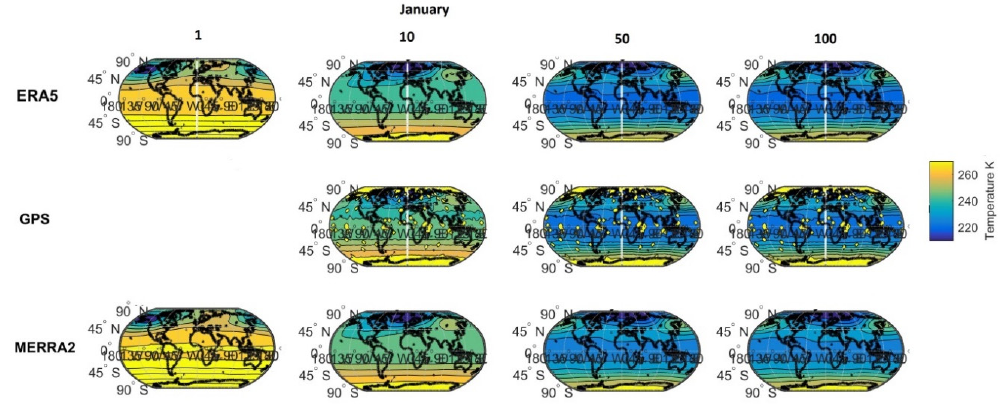
Figure 2. Temperature climatology for January, period 2004–2018. ERA5 reanalysis on the top panels, GPS RO on middle panels, and MERRA2 on the bottom panels for pressure levels 1, 10, 50, and 100 hPa.